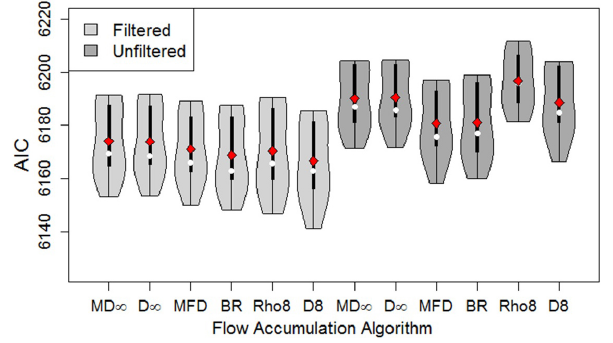
Figure 9. AIC values vs. flow accumulation algorithm for the fil- tered (light grey) and unfiltered (dark grey)